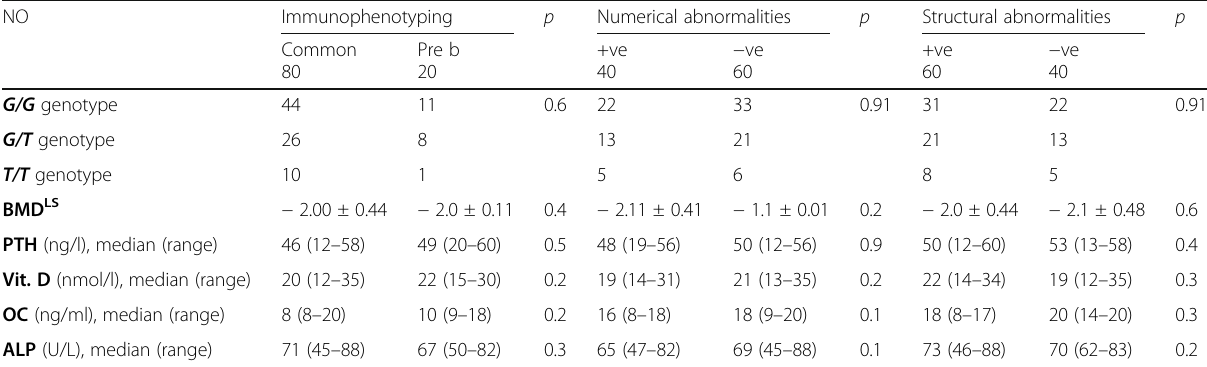
Table 5 Genetic and laboratory characteristics of the patients regarding the immunophenotype characteristics and chromosomal abnormalities (numerical and structural) in ALL patients (during the second assessment)